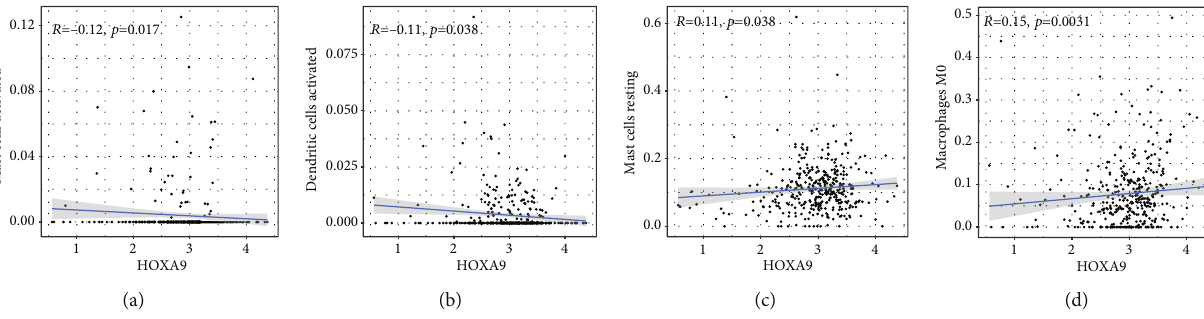
Figure 11: (a – d) Scatter plot presenting the association of 4 types of TIC proportion with the expression of HOXA9. R = – 0.11, p =0.04